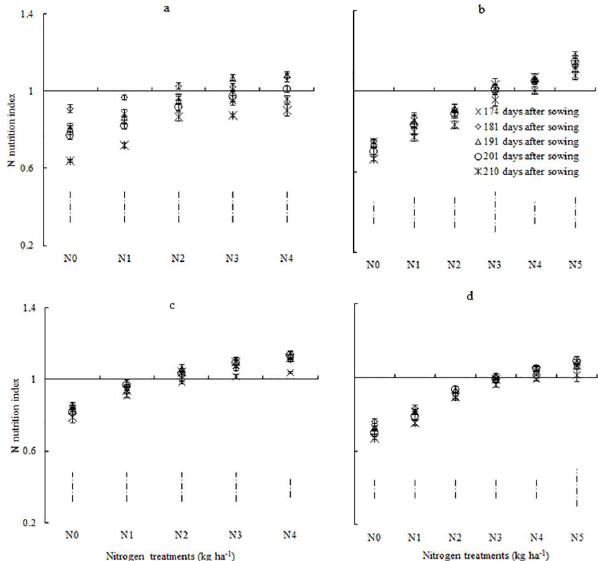
Fig 6. Changes in the N nutrition index for YM16 and NM13 during the reproductive growth period. a: 2009–2010 NM13, b: 2010–2011NM13, c: 2009–2010YM16, d: 2010–2011 YM16. The vertical bars represent standard error of the mean value on each samplingdate. The vertical dotted bars without line end represent LSD values ( P < 0.05) on each samplingdate.